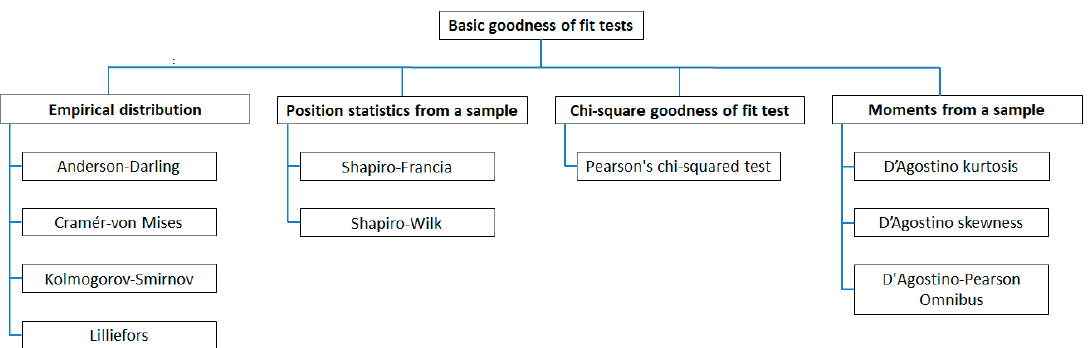
Figure 4. Division of basic statistical tests used to examine the consistency of empirical distribution with the theoretical normal distribution. Own study based on: [23].